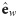
EPDFs for the angles θw (red) and θs (blue) between the eigenvectors e^w and e^s of B, respectively, and the unit tangent e^t (Eq (5)), each plotted vs. participant/condition. All other figure details are as in Fig 6.We see that in all cases 0 ≈ |θw| ≪ θs (θw = 0.90° [−2.36°, 3.99°] and θs = 79.75° [20.66°, 144.75°]). The orientation of the weakly stable subspace was found to be nearly tangent to the GEM, with a small range of variation, whereas the strongly stable subspace made a much greater angle with the GEM and varied substantially. Together with the results of Fig 6, these results confirm hypotheses H1 and H2.